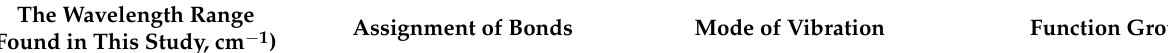
Table 3. Functional groups and mode of vibration from FTIR spectra of